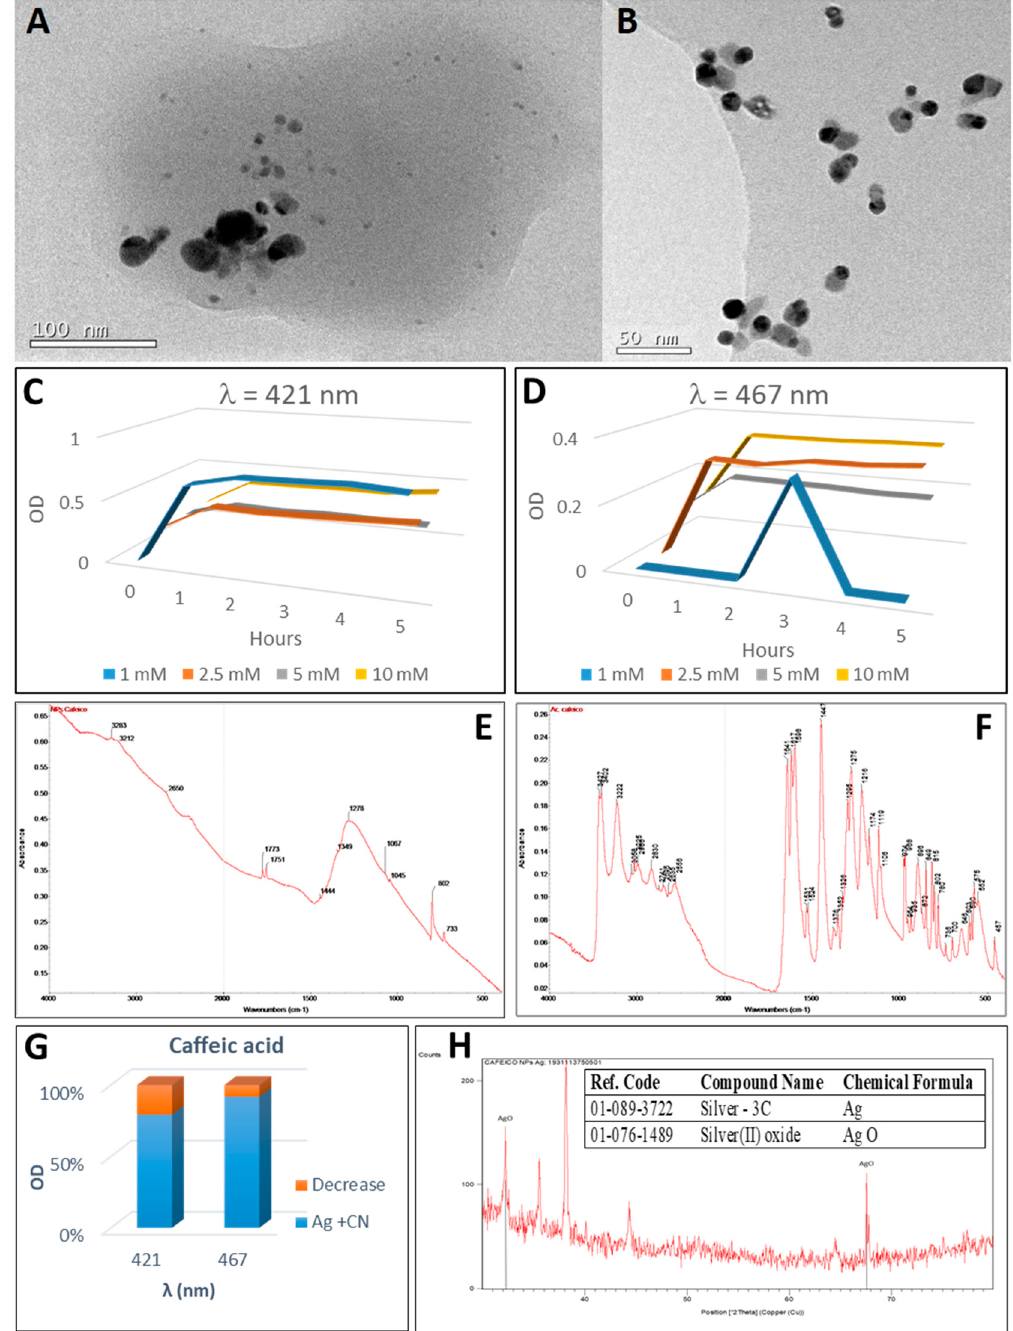
Figure 8. Analysis of silver nanoparticles synthesised with caffeic acid. ( A ) TEM image of AgNPs prior treatment with cyanide. ( B ) TEM image of AgNPs after treatment with cyanide. ( C , D ) Scheme 3. concentrations with caffeic acid for 5 h (in one-hour intervals). C: maximum at wavelength 421 nm (50 nm diameter nanoparticles). ( D ) maximum at wavelength 467 nm (80 nm diameter nanoparticles). ( E , F ) FTIR spectra of caffeic acid-derived nanoparticles ( E ) and caffeic acid ( F ). ( G ) decrease in OD after cyanide addition to silver nanoparticles. ( H ) XRD profile of the AgNPs obtained by the reaction of caffeic acid with AgNO 3 ; in the insert, the table with the identifications. Peaks identifying the presence of silver oxides have been indicated in the XRD diffractogram.